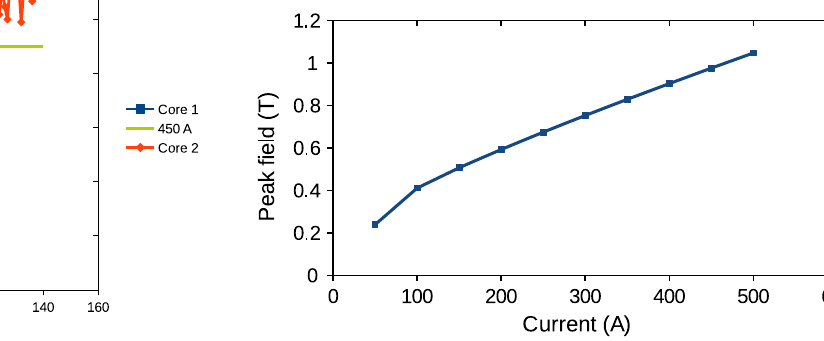
FIG. 8. Quench currents during training of cores. FIG. 9. Magnet excitation